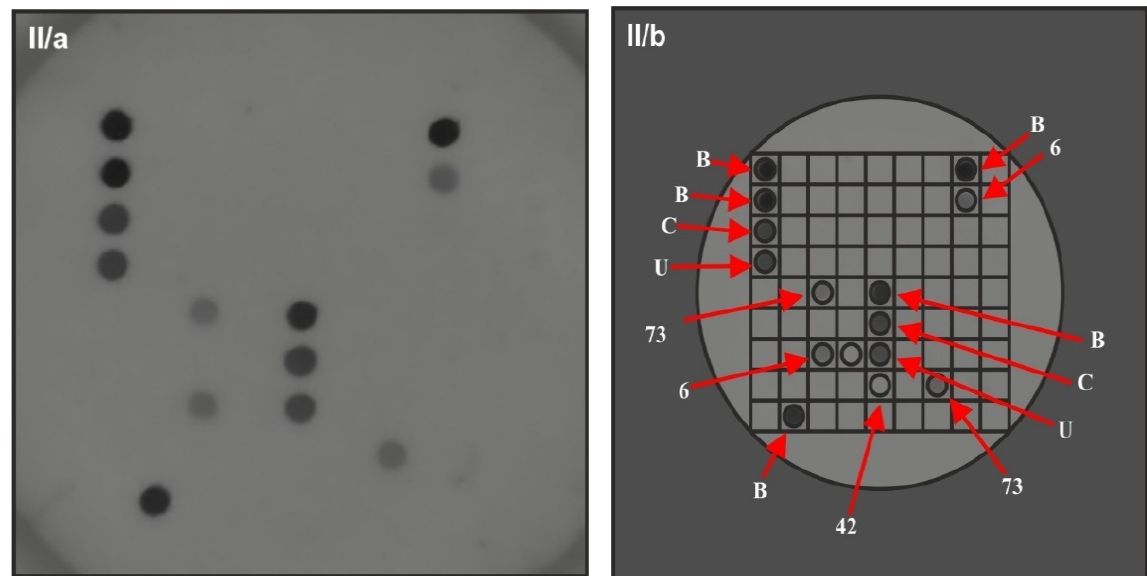
Figure 2. HPV genotype detection with Direct Flow CHIP test. I: Low-risk 6, 42, 44/55 and 67 HPV genotype multi-infection in patient with external anogenital warts. ( I/a , I/b ): snapshots before and after processing with hybriSoft software. Controls and the HPV genotypes were tested in duplicates. II: Low-risk 6 and high-risk 73 HPV genotype coinfection in patient with external anogenital warts. ( II/a , II/b ): snapshots before and after processing with hybriSoft software. Spot B: Hybridization control (5 signals to orientate the CHIP). Spot C: Internal DNA control (genomic human DNA probe). Spot U: HPV universal probe.